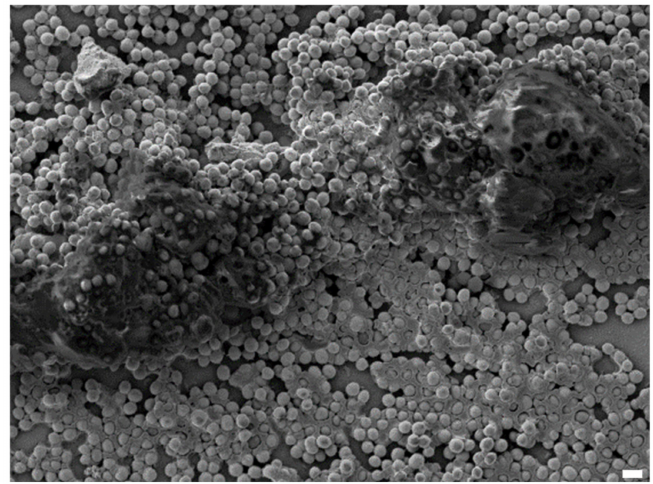
Figure 1. Scanning electron microscopy acquisition of S. aureus biofilm in vitro. Scale bar = 1 µ